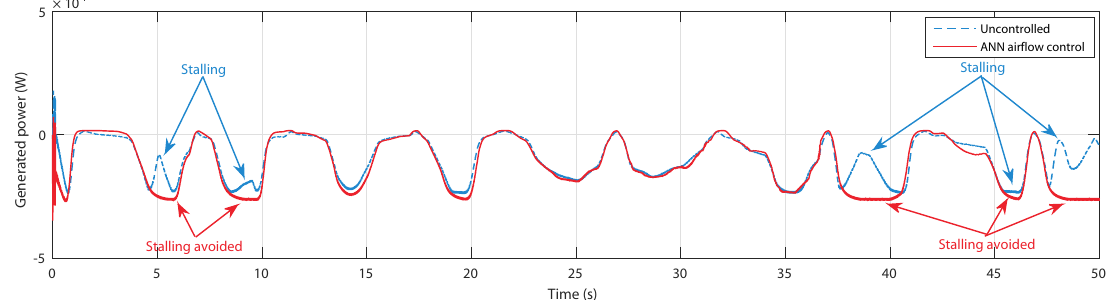
Figure 23. Generated power for uncontrolled case and ANN-based airflow control. For a final comparison, Figure 24 shows the output power of the OWC measured in the Mutriku facility at the same time and on the same day (12 May 2014, at 00:00:00). These data were provided by the Basque Energy Agency